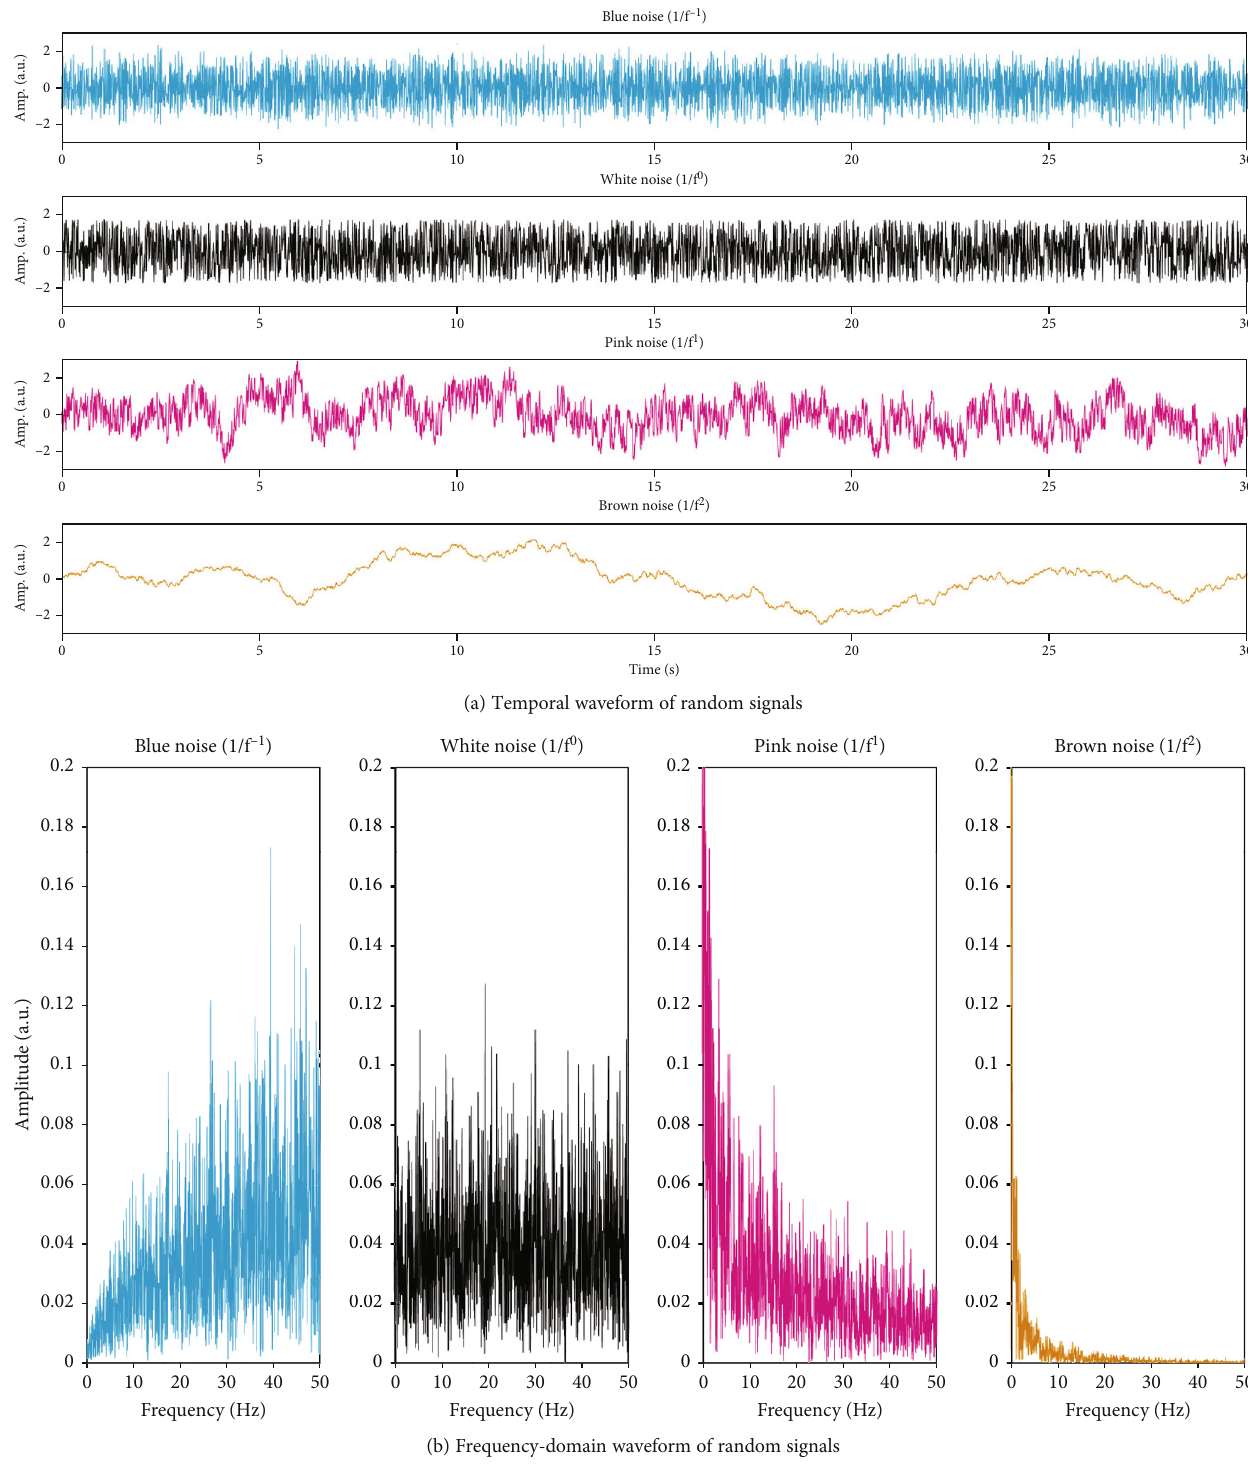
Figure 2: Time-domain waveform and frequency-domain waveform of random